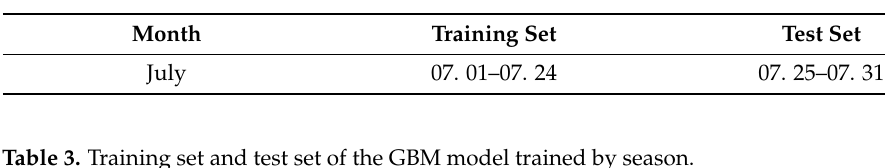
Table 2. Training set and test set of the GBM model trained by month.